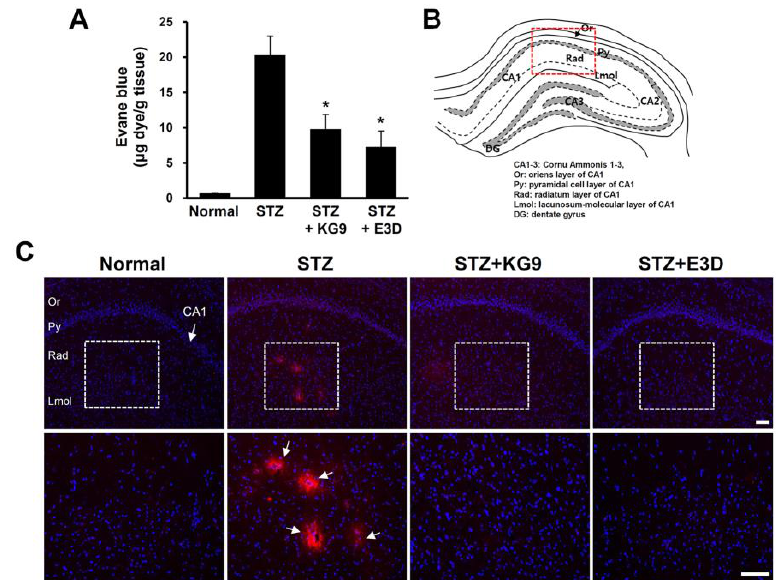
Figure 3. GS-KG9 and GS-E3D inhibit the increase in blood – brain barrier (BBB) permeability in the hippocampus of STZ-induced diabetic rats. For measuring BBB permeability, 5 mL of 2% Evans blue dye was administered i.p. at 28 d after drug treatment, and 3 h later, brain tissue samples were prepared for detection of Evans blue extravasation ( n = 5 rats/group). ( A ) Quantification of the amount of Evans blue in hippocampus by using fluorometer (excitation at 620 nm/emission at 680 nm). Note that both GS-KG9 and GS-E3D significantly attenuate the increase in Evans blue extravasation in STZ-induced diabetic rats as compared to STZ control. Data are expressed as the mean ± SD. ( n = 5 rats/group). * p < 0.05 vs. STZ control. ( B ) Atlas of hippocampal structure. ( C ) Representative images showing Evans blue extravasation in CA1 area (red box in Figure 3B). The bottom panels are higher magnification images of the box area in the upper panels. Arrows indicate Evans blue extravasation. Red, fluorescence signal; blue, DAPI (4 ’,6 -diamidino-2-phenylindole)stained signal. Note that the fluorescence intensity of Evans blue in the hippocampal radiatum layer (Rad) was significantly reduced in GS-KG9 and GS-E3D (300 mg/kg) treated rats when compared to that in STZ control. Scale bars, 100 μm.